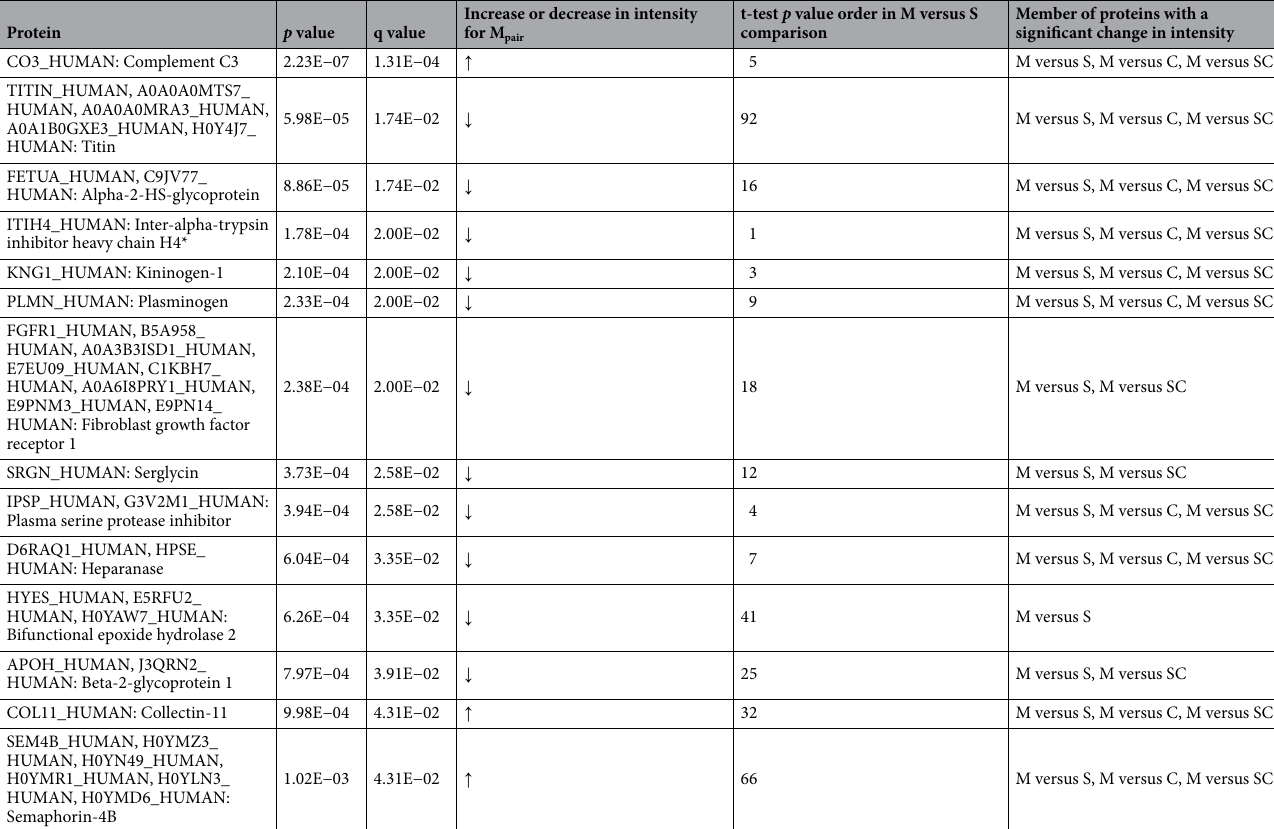
Table 5. Proteins with a significant change in intensity in a pairwise comparison of samples. Proteins with a significant change in intensity in a group of 10 patients in a pairwise comparison of samples from the acute poisoning phase (M pair ) and the long-term surviving phase (S pair ). *MaxQuant search id